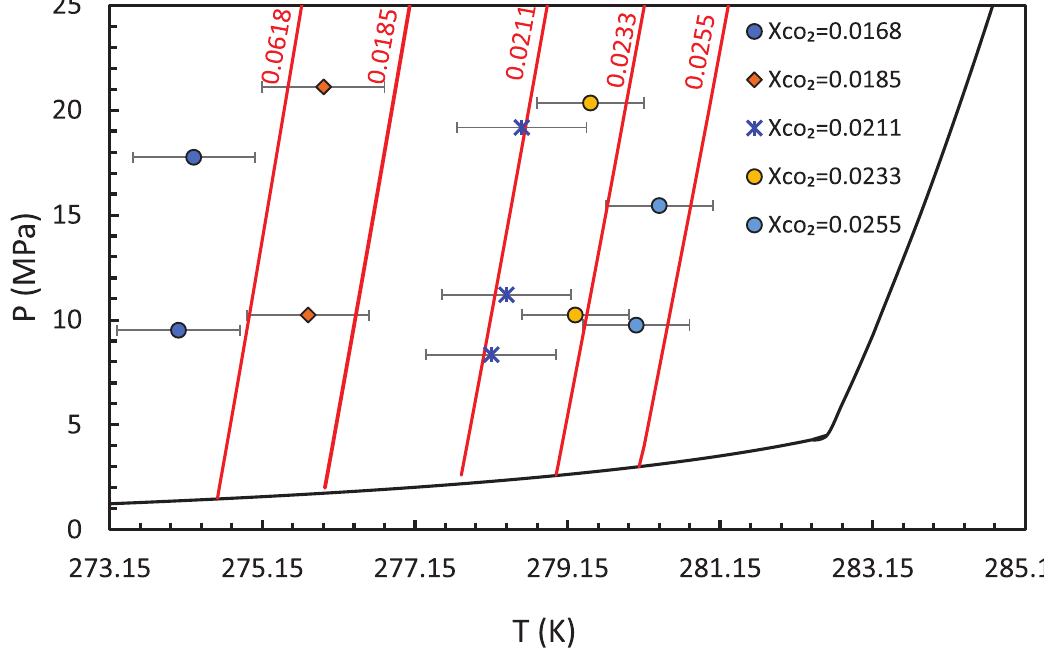
Fig. 6. Experimental and predicted hydrate equilibrium temperature at CO 2 isopleth ( x CO2 is in mol fraction) in distilled water (red lines: HL w predictions; black lines: VHL w /LHL w predictions).